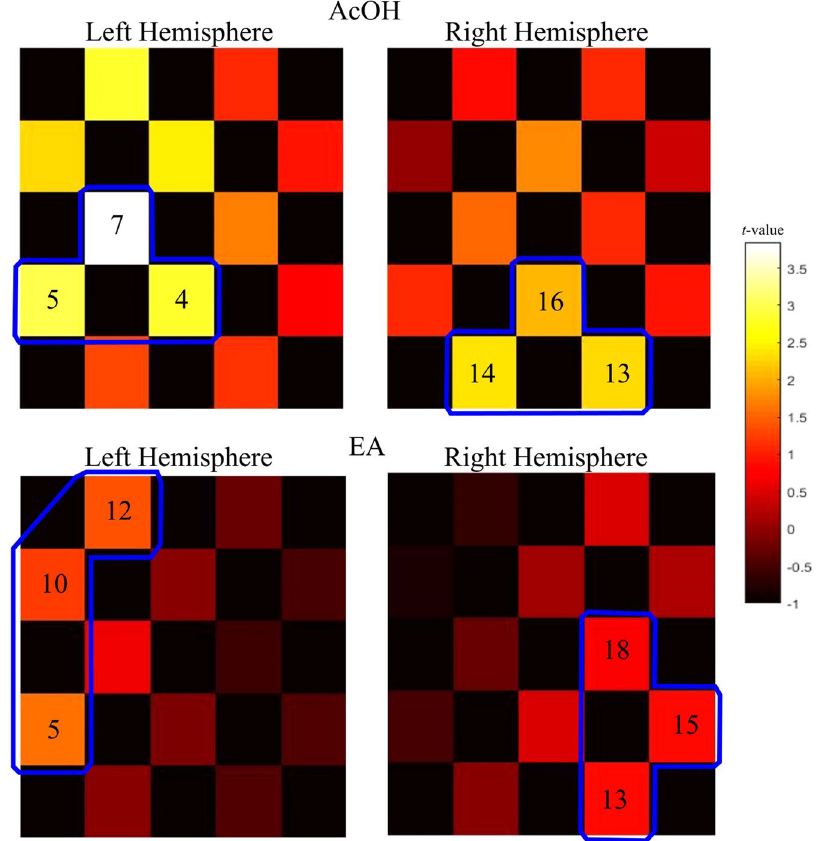
Figure 1. T -maps showing hemodynamic (HbO) changes after stimulus presentation. The color-coding represents t -values obtained from paired t -tests between interval of interest [10–15 s] and baseline. Channels selected for further analyses are marked in blue. Top figure: t -maps for birhinal AcOH stimulation for the left and right hemispheres. Bottom figure: t -maps for birhinal EA stimulation for both hemispheres,